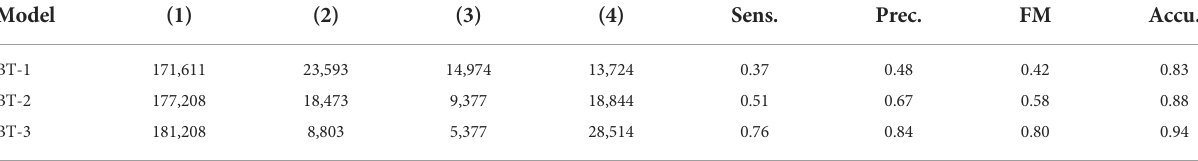
TABLE 3 Performance evaluation of three machine learning models using test